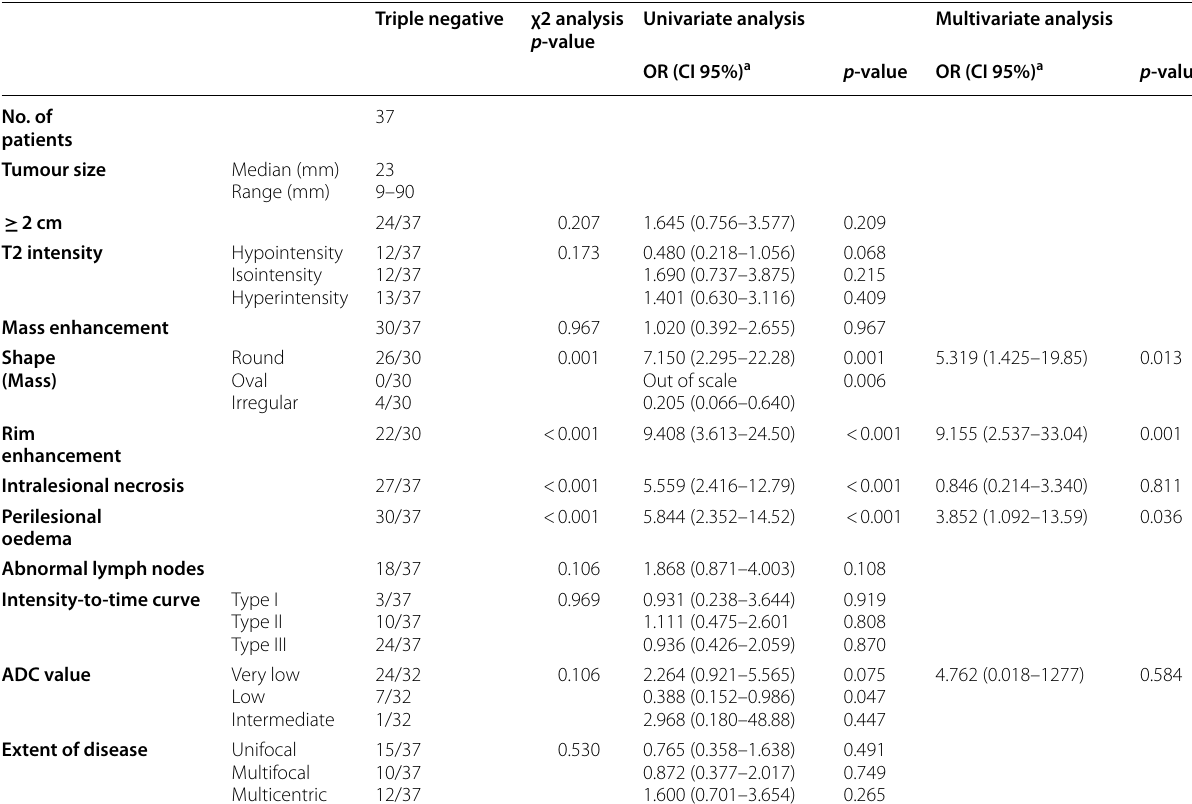
Table 6 Correlation between triple-negative tumours and magnetic resonance imaging features